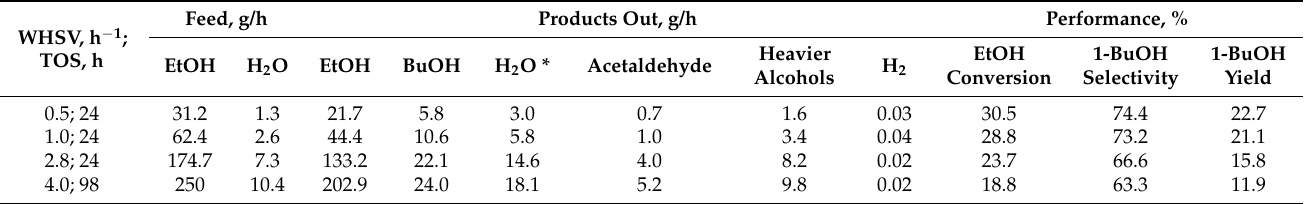
Table 5. Results of testing experiments conducted with hydrous ethanol in a mini-pilot rig packed with C-HAP-30% SiO 2 . Feed, g/h Products Out, g/h Performance, % WHSV, h − 1 ; TOS, h